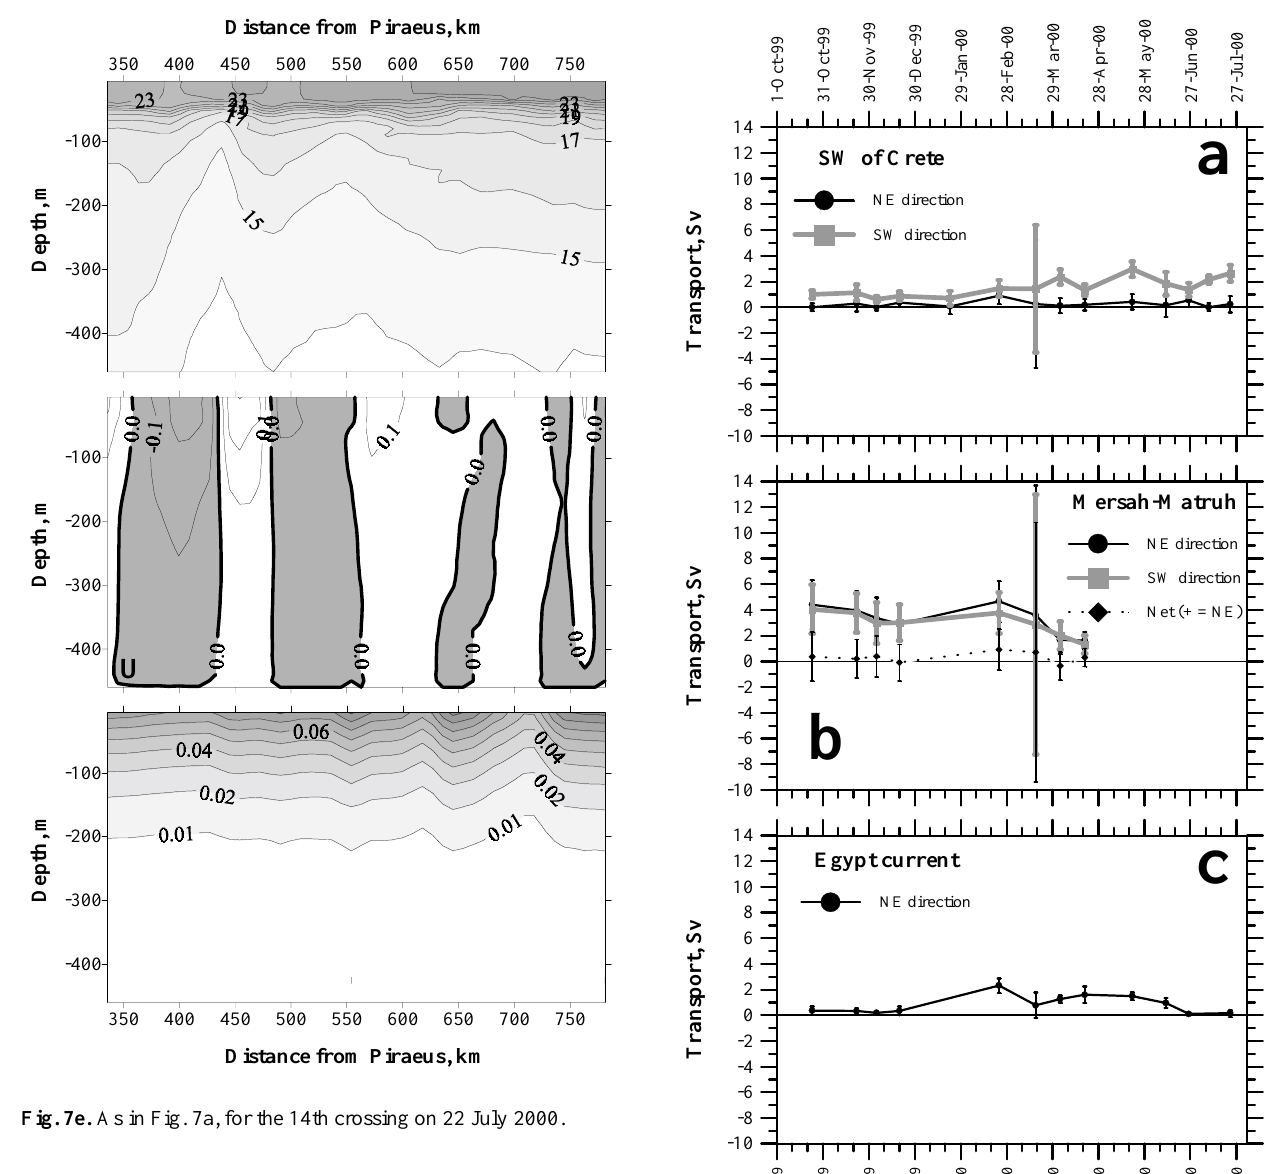
images of the region.